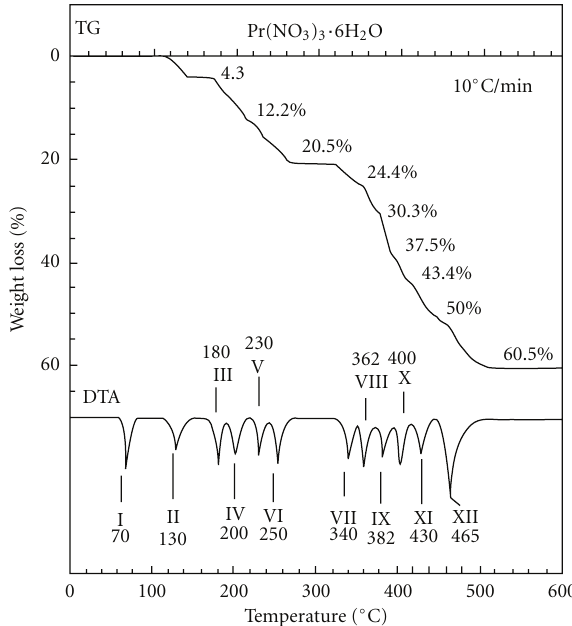
Figure 5: TG and DTA curves recorded for praseodymium nitrate at the heating rates indicated, in static air. Reproduced from Thermoch. Acta , 2001, 369 , 59. Copyright 2001, Elsevier [11].